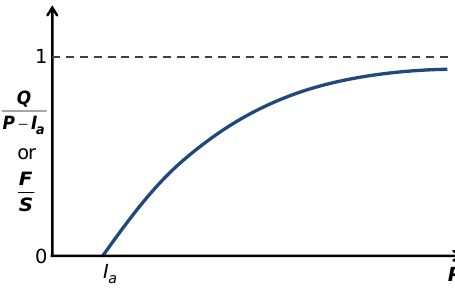
Figure 1. Presumed variation of the ratios in Eq. (2) with event rain- fall ( P ). Q is event runoff, I a is initial abstraction, F is cumulative infiltration after runoff begins, and S is potential maximum reten- tion (modified from Rallison and Miller, 1982, Fig.